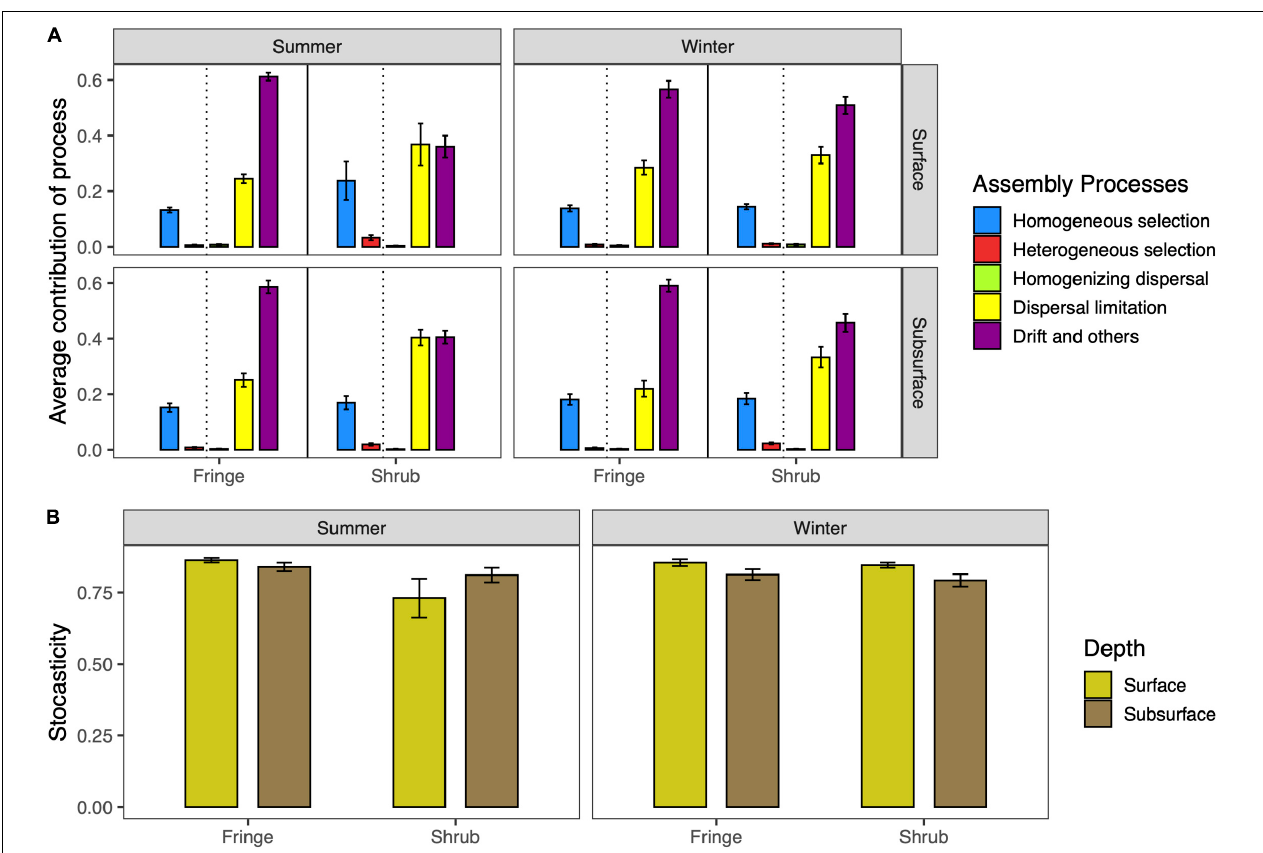
FIGURE 9 | (A) Average contribution of bacterial community assembly processes across seasons and location factors. The processes are calculated from distance based phylogenetic structure analysis in the icamp package in R. The dotted line separates the deterministic processes (left side of line) from the stochastic processes (right of line). (B) The sum of the stochastic processes across experimental factors. The bars are represented as the mean of the relative values ±